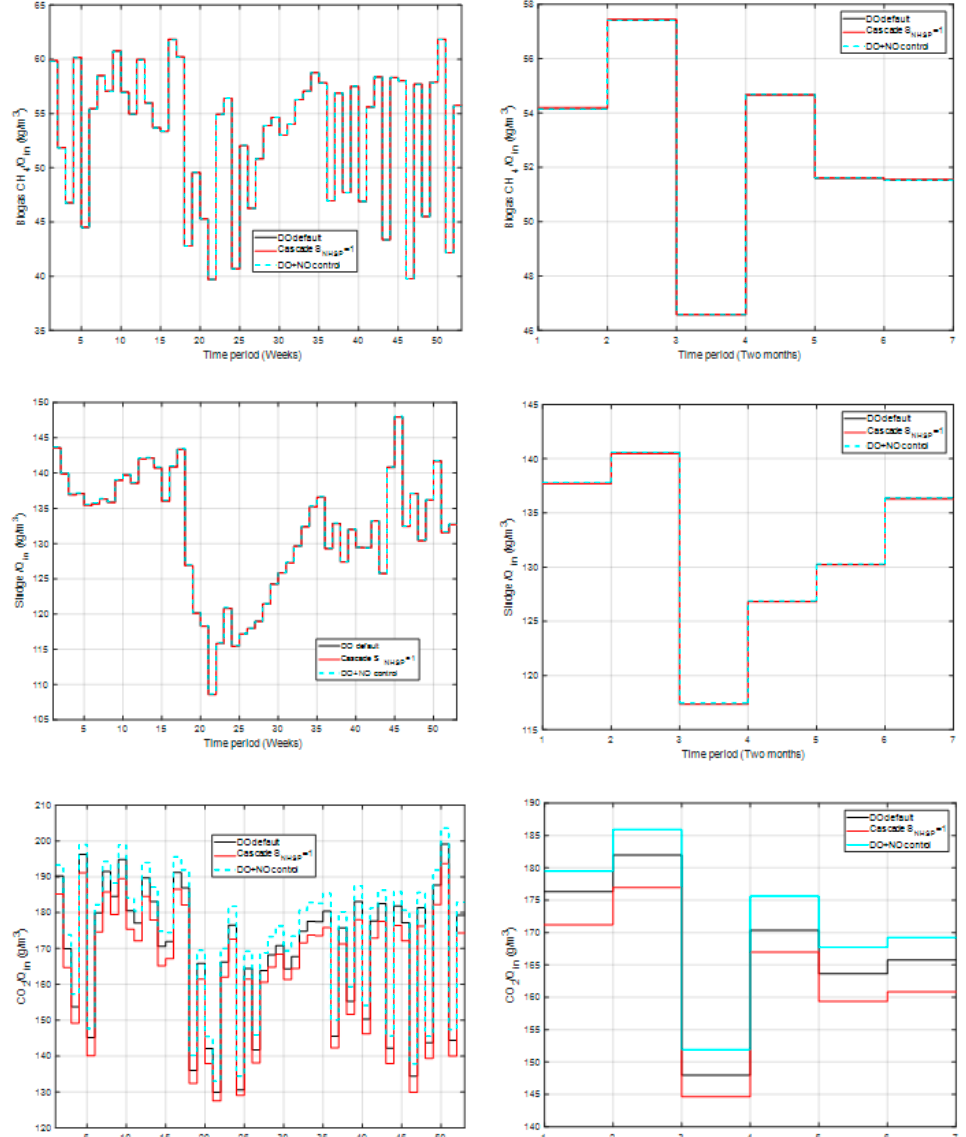
Figure 5. Weekly and bimonthly profiles of environmental indicators associated with emissions to air and soil: methane content in biogas, Biogas CH 4 /Q in (kg/m 3 ), sludge for disposal, Sludge/Q in (kg/m 3 ), and total carbon dioxide emissions, CO 2 /Q in (g/m 3 ).